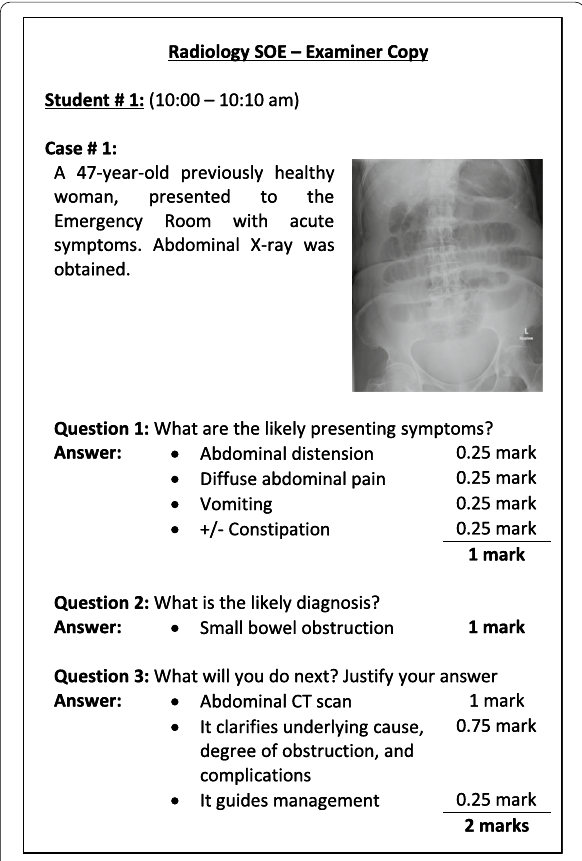
Fig. 2 Sample of scoring guide given to the examiners. The order of scheduled student (first students from each batch here) and start time and end time are shown in the scoring guide to easily keep track of